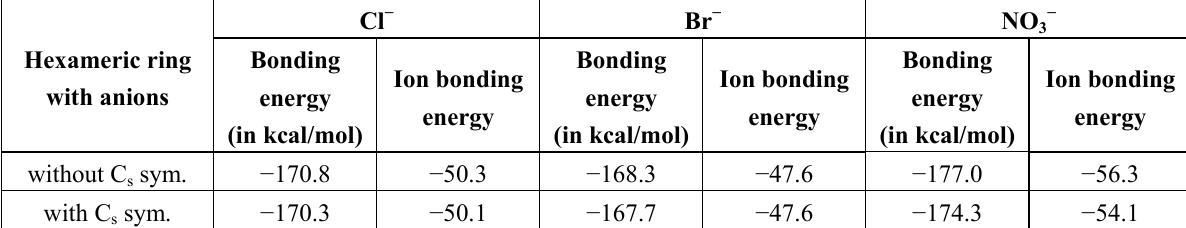
Table 2. Bonding energies and ion bonding energies (in kcal/mol) of hexameric m 7 G ring in the presence of selected anions (Cl − , Br − and NO and without C s